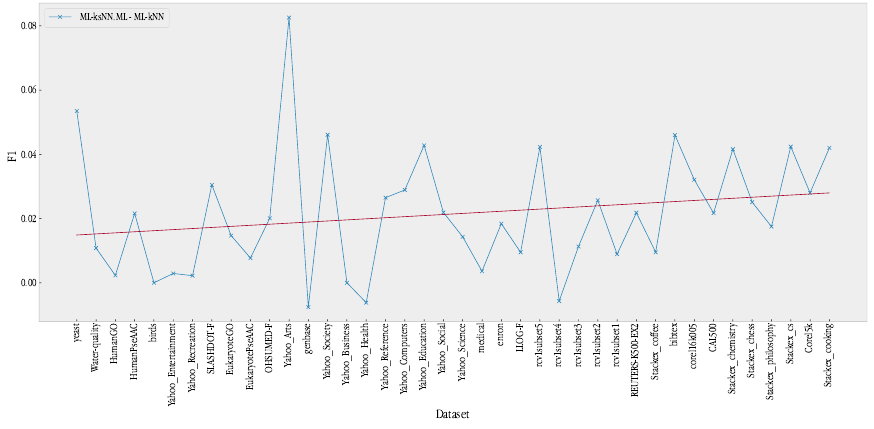
Figure 7. Difference in F1 metric between ML-k’sNN.ML and ML-kNN, sorted by increasing number of dataset labels. A linear regression of the difference in terms of the F1 metric is plotted in red color.